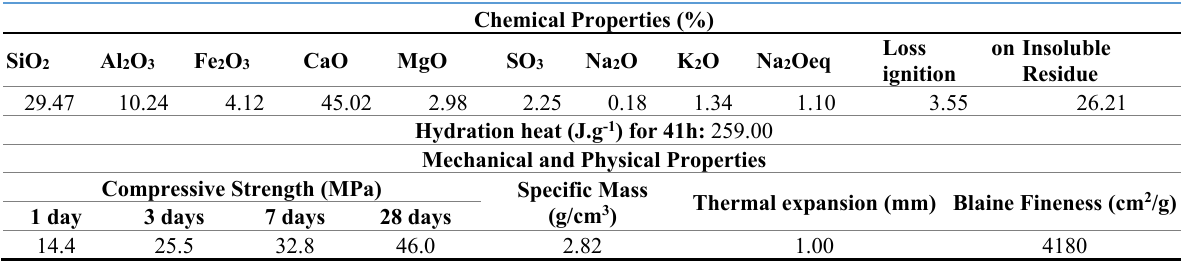
Table 2. Properties of the Portland-pozzolan cement, ASTM Type IP.